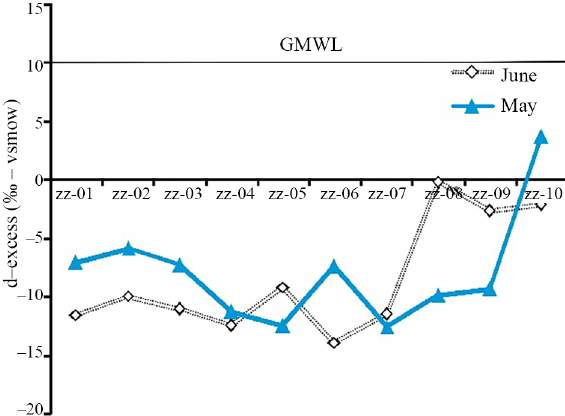
Figure 4. Changes in